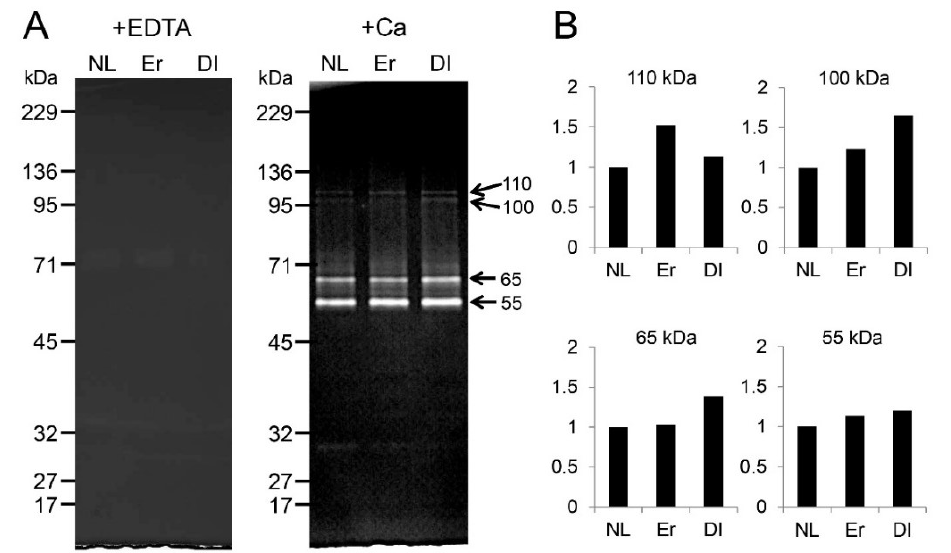
Figure 6. Effect of LI on porcine dental pulp tissues. ( A ) Zymogram using a gelatine gel as the substrate incubated with EDTA (left) or Ca 2+ (right). Ten micrograms of protein extracted from porcine dental pulp tissues were used for zymography. ( B ) Densitometry analysis of 110 kDa, 100 kDa, 65 kDa, and 55 kDa protease bands. The intensity of the protease bands on the gelatin zymogel was determined using ImageJ software and normalized to the intensity of NL to compare the effect of LI. NL: without LI; Er: Er:YAG-LI; Dl: diode-LI.